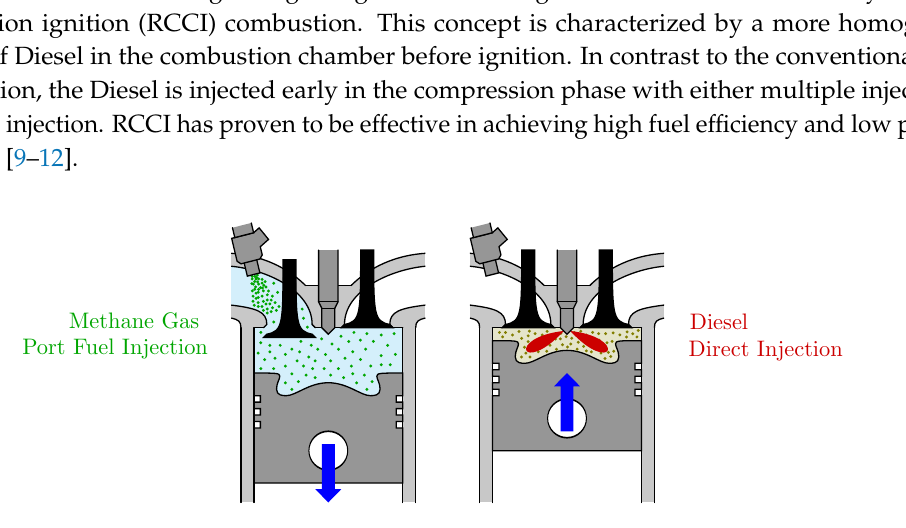
Figure 1. Principle of operation for a Diesel-ignited gas engine. The port fuel injected methane gas is ignited by a small amount of direct-injected Diesel fuel